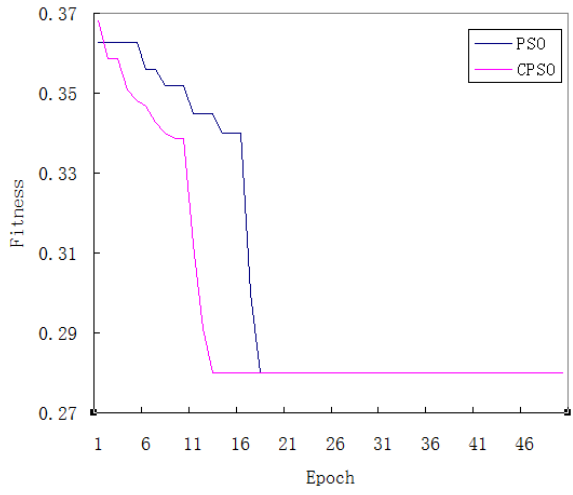
Figure 2. Iterative curves of the classic linear kernel function. CPSO, cloud PSO.